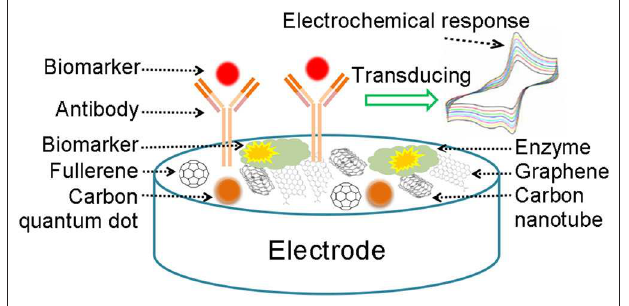
FIGURE 1 | A schematic representation of electrochemical